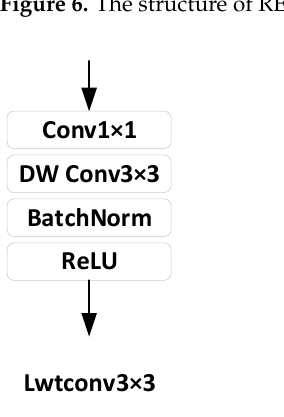
Figure 7. The structure of Lwtconv3×3.